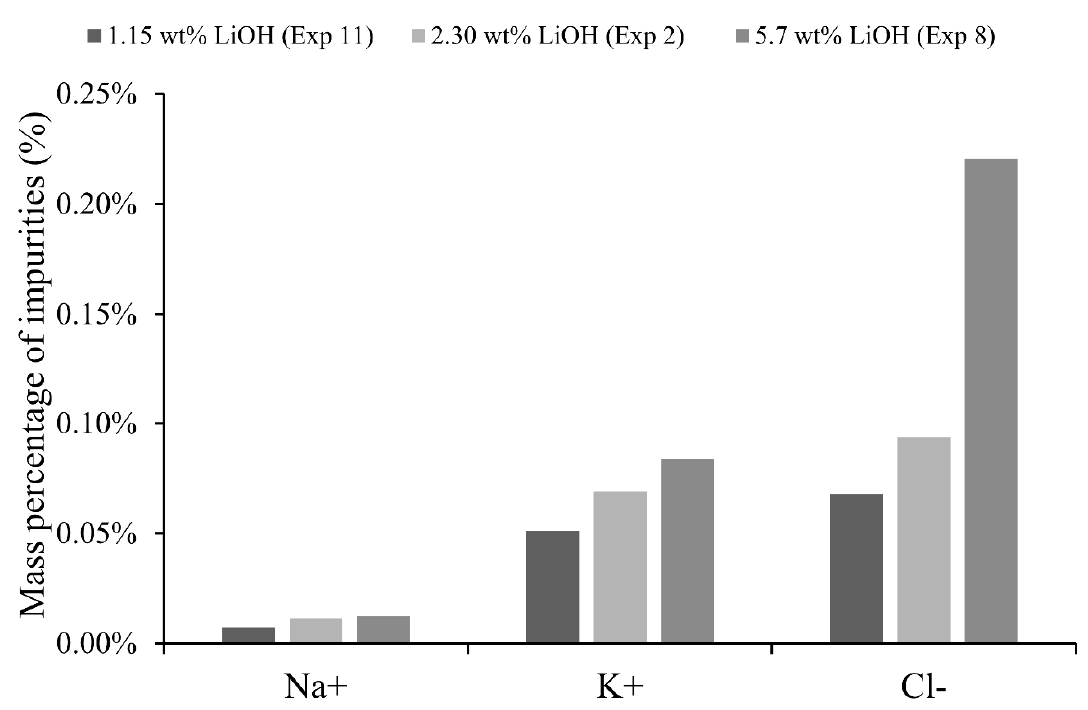
Figure 11. Impurities of Na, K and Cl in final catholyte according initial concentration of LiOH.